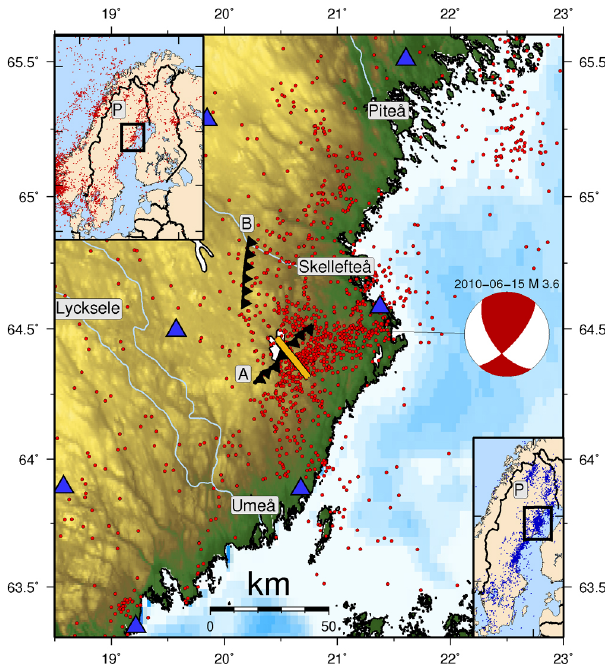
Fig. 1. Seismicity and postglacial faults in the Skellefte˚a area. Fault A is the Burtr¨ask fault and fault B the R¨ojnoret fault. The P in the insets shows the location of the southwestern end of the P¨arvie fault. Red dots are earthquakes located by the Swedish National Seismic Network (SNSN) since 2000, blue triangles show SNSN stations and the yellow line is the reflection profile. Focal mechanisms of the 15 June 2010, M3.6 earthquake. The upper left inset shows the seismicity of Fennnoscandia between 1960 and 2001 from the University of Helsinki FENCAT catalogue. The lower right inset shows the seismicity of Sweden recorded by the SNSN between 2000 and June